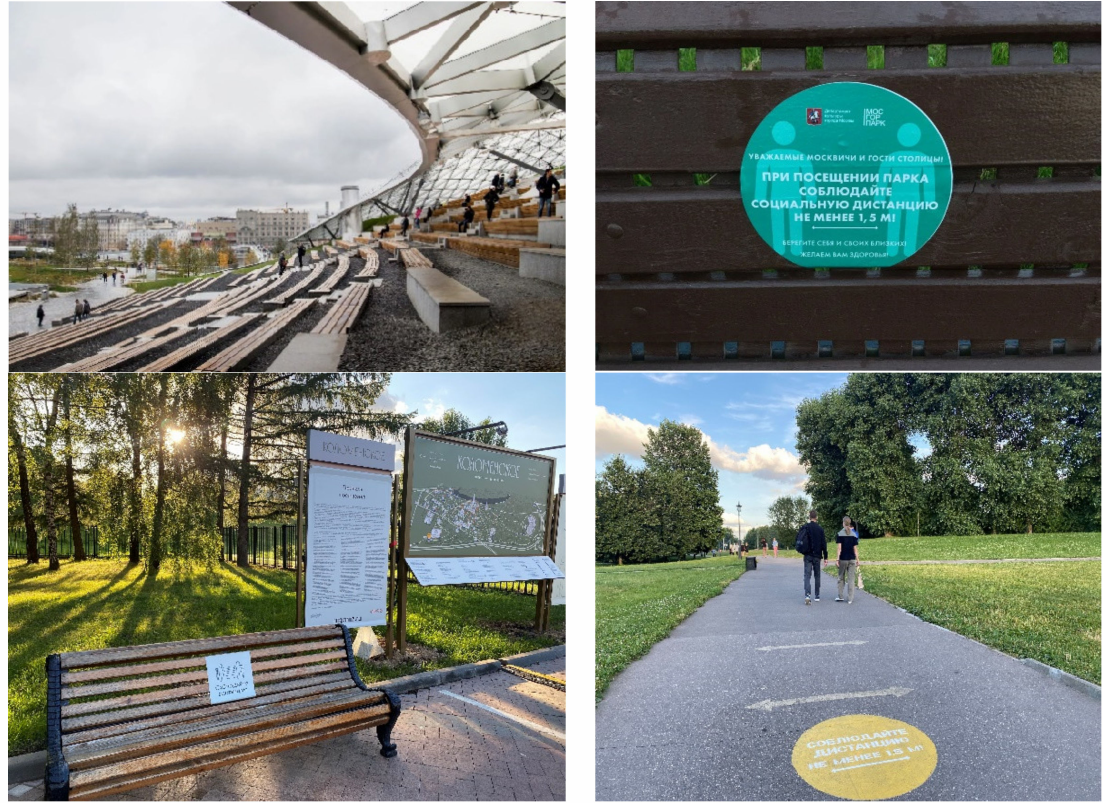
Figure 14. Social distancing (signboards indicating respect for social distancing of no less than 1.5 m) in Zaryadye park ( first line ) and Kolomenskoe Park of Moscow ( second line ). Photos: D. Dushkova,